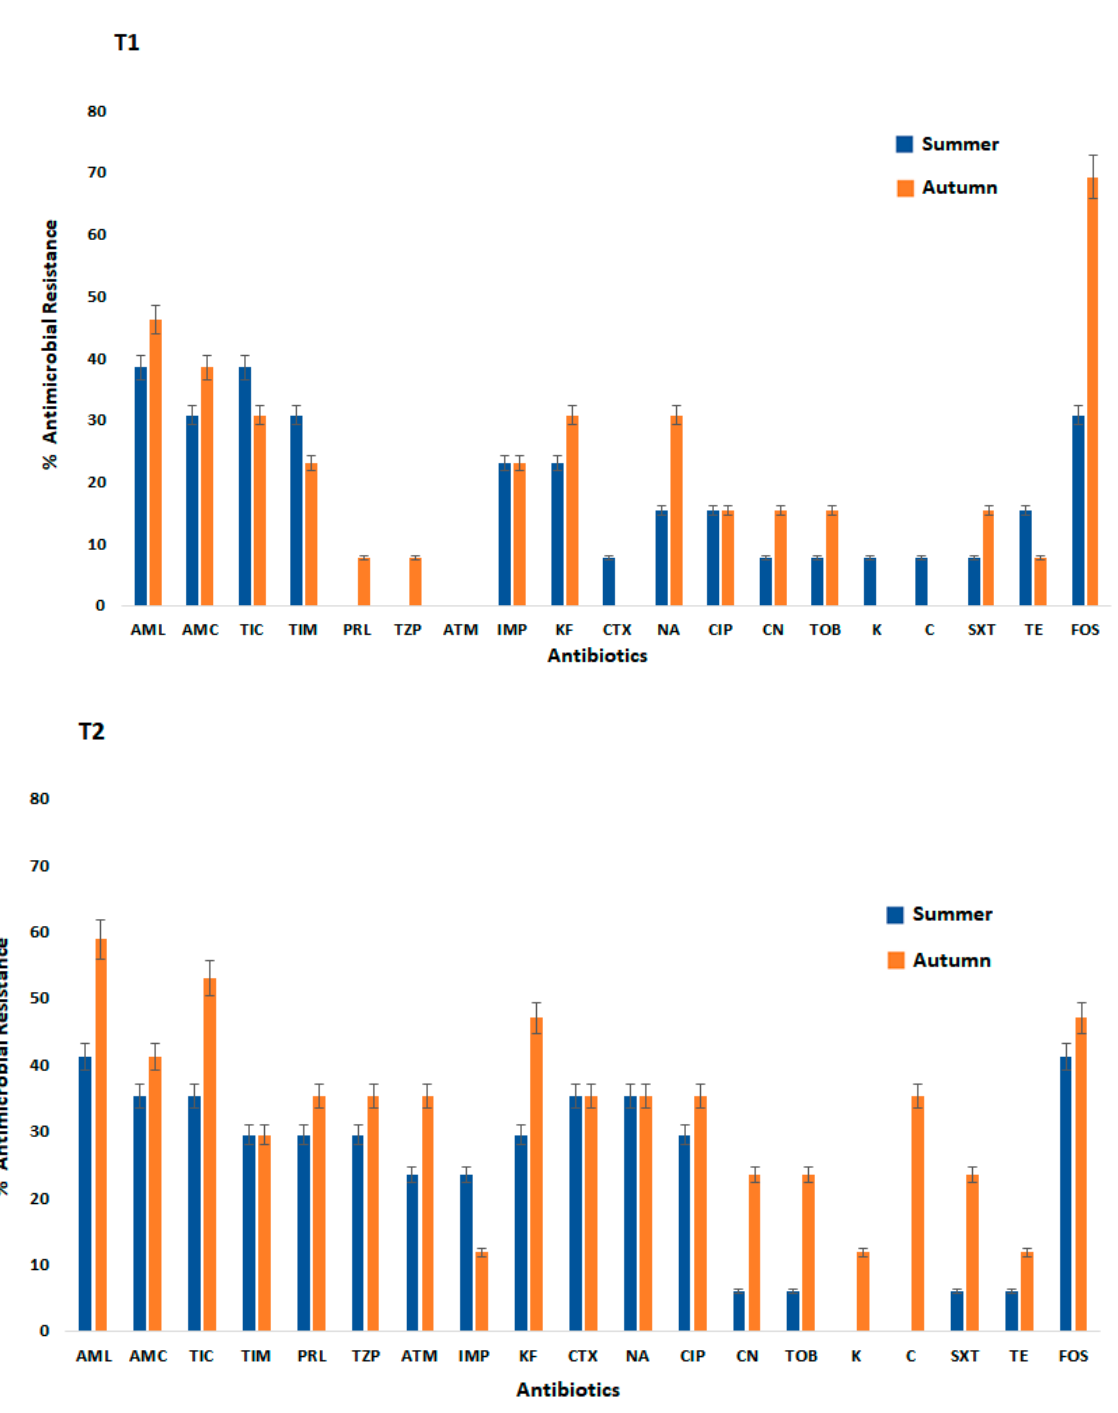
Figure 4. Percentage of antimicrobial-resistant bacteria for each sampling site (T1 and T2) by seasons (summer—blue color vs. autumn—orange color). Values were expressed as ths mean of resistant Aeromonas spp. ± standard deviation, for the same antimicrobial. No lettering indicates non-significant differences at a 95% confidence level. Antibiotic abbreviations: